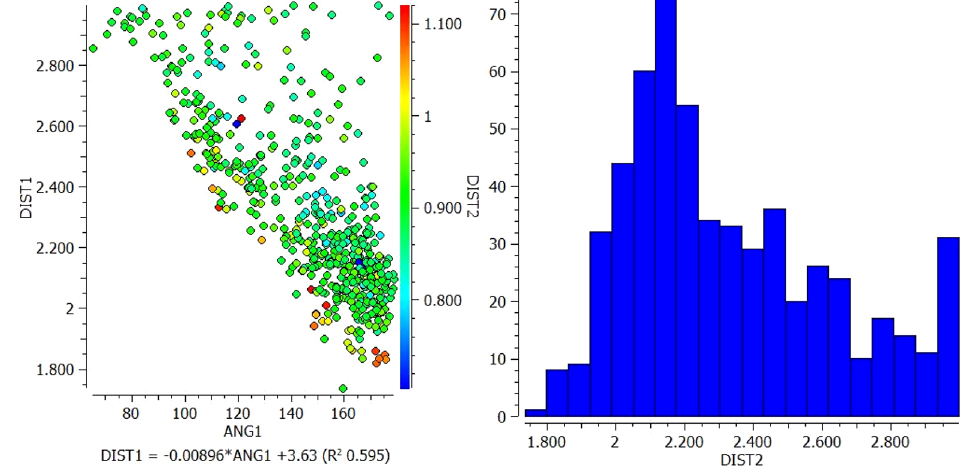
Figure 1. Scatterplot of DIST 1 versus ANG and histogram for N13 of VEM and NH18 of